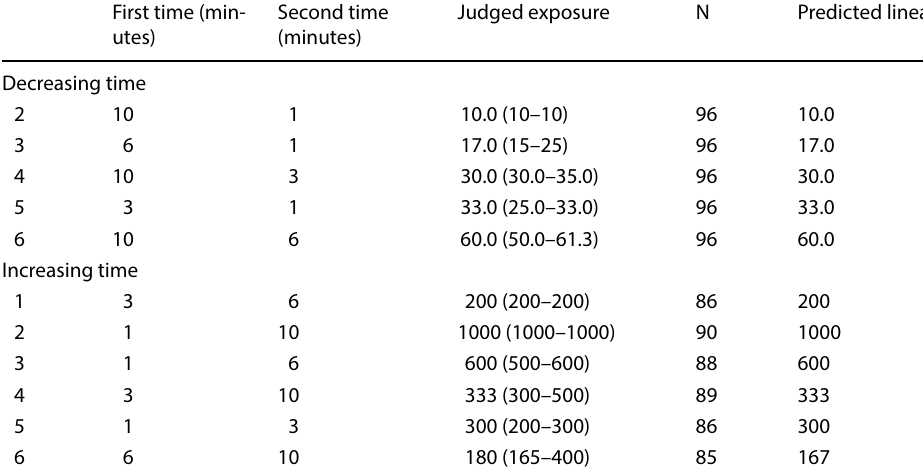
Table 2 Medians and quartiles of judgments and predictions according to a linear model. Decreasing and increasing time of